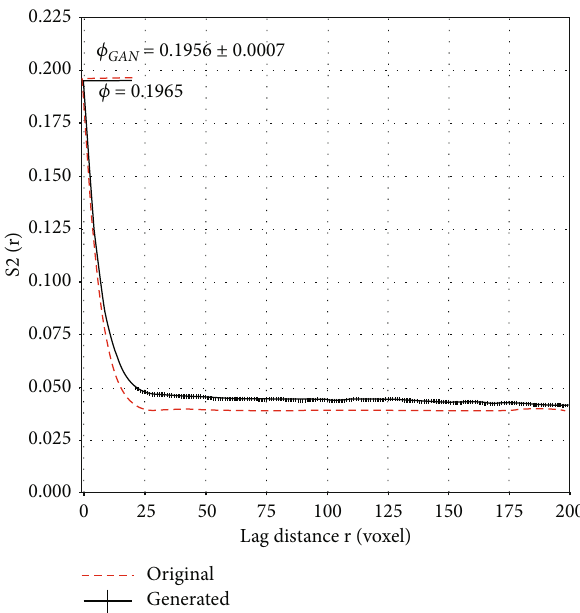
Figure 6: Radial covariance functions of generated core samples and training